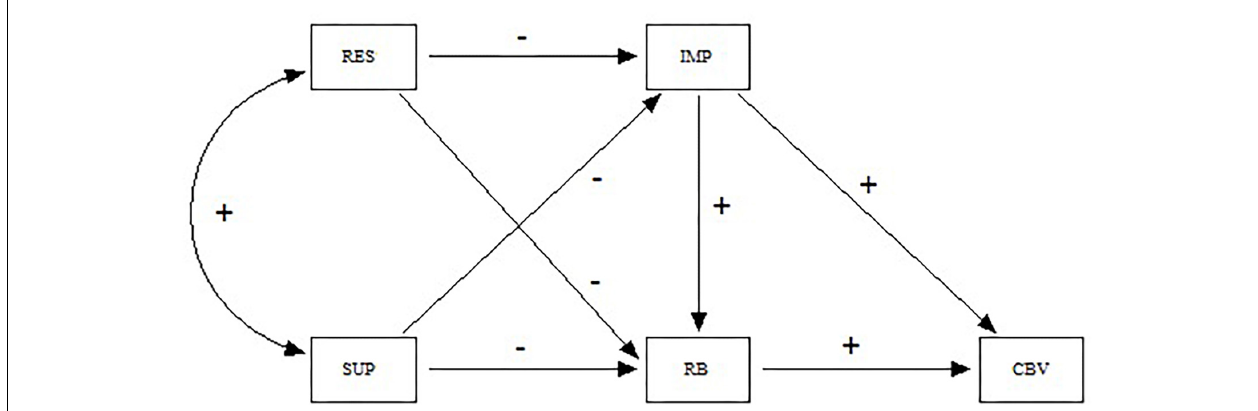
FIGURE 1 | Starting theoretical model (RES, restriction; SUP, supervision; IMP, impulsivity; RB, risk behaviors; CBV, cyber-victimization; + , positive relation; − , negative